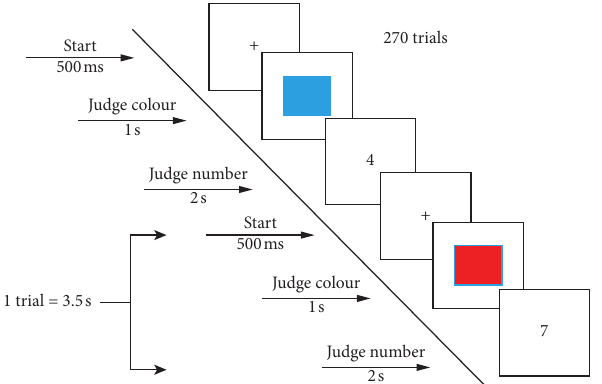
Figure 5: Conceptual illustration of the task switching test.